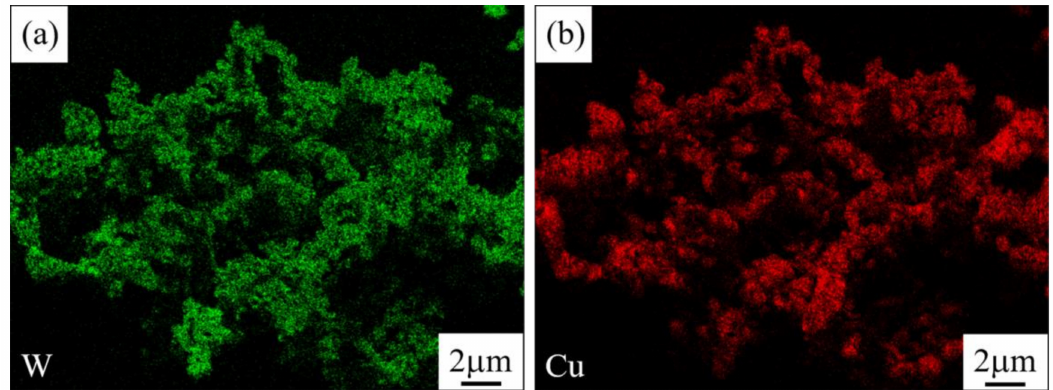
Figure 15. EDS distribution diagram of Figure 14e: ( a ) W; ( b ) Cu.